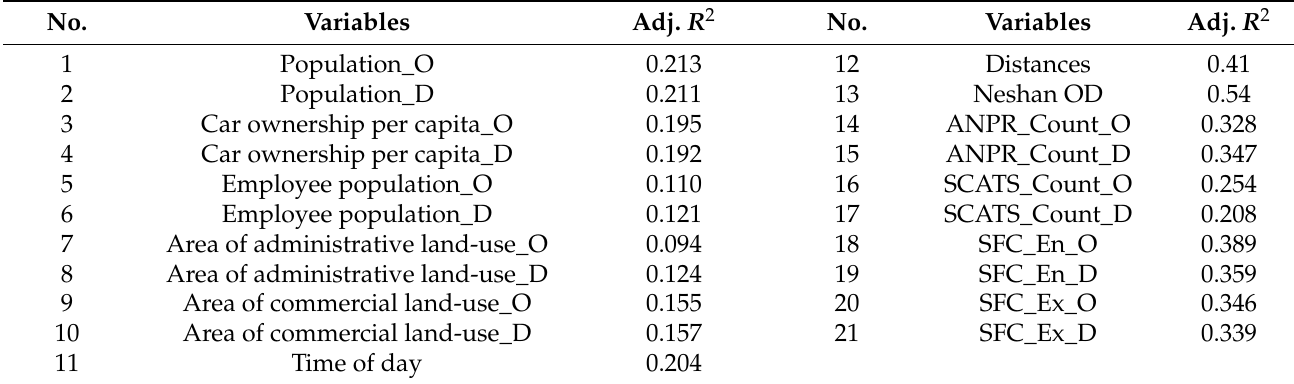
Table 2. Adjusted R 2 value for independent